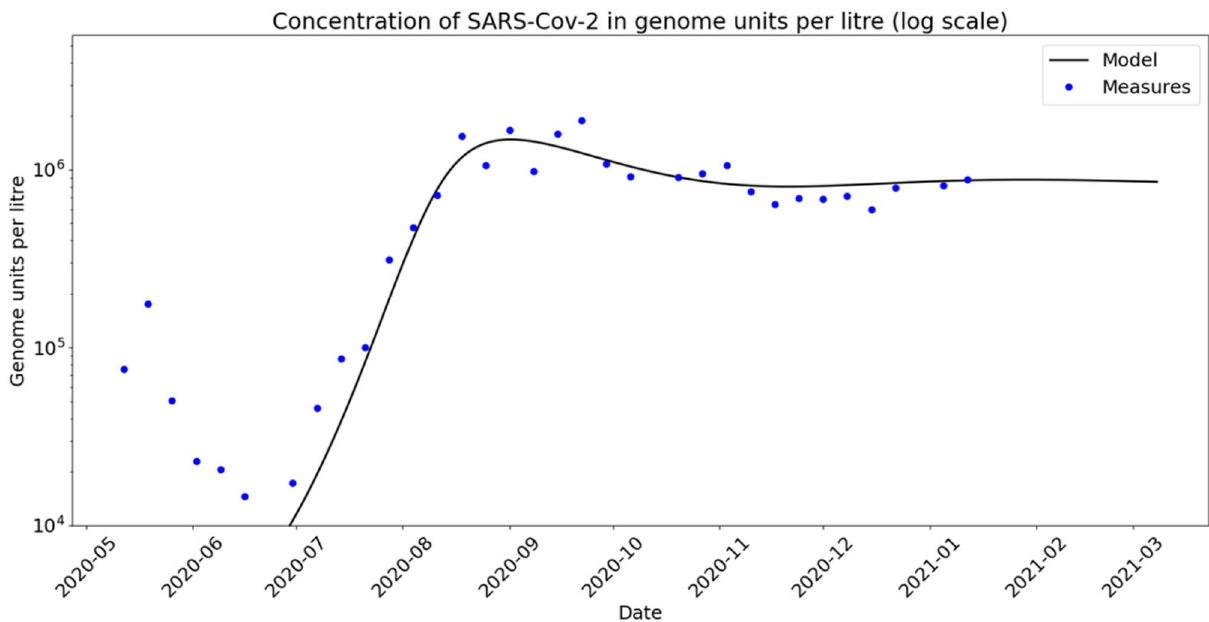
Figure 5. Calibrated model on Sète area: blue dots are measures of SARS-CoV-2 genome units and black curve represents the total infected individuals as an output of the model discretized into n g = 20 groups in a . Initial distribution of susceptible individuals and β function are taken as described in supplementary information.